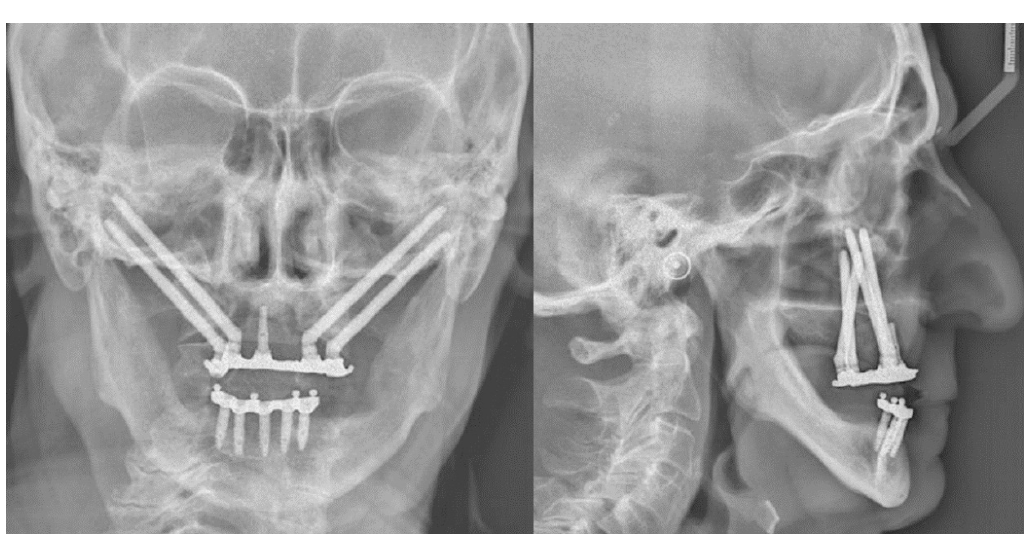
Figure 8. Postoperative frontal and lateral radiographs.